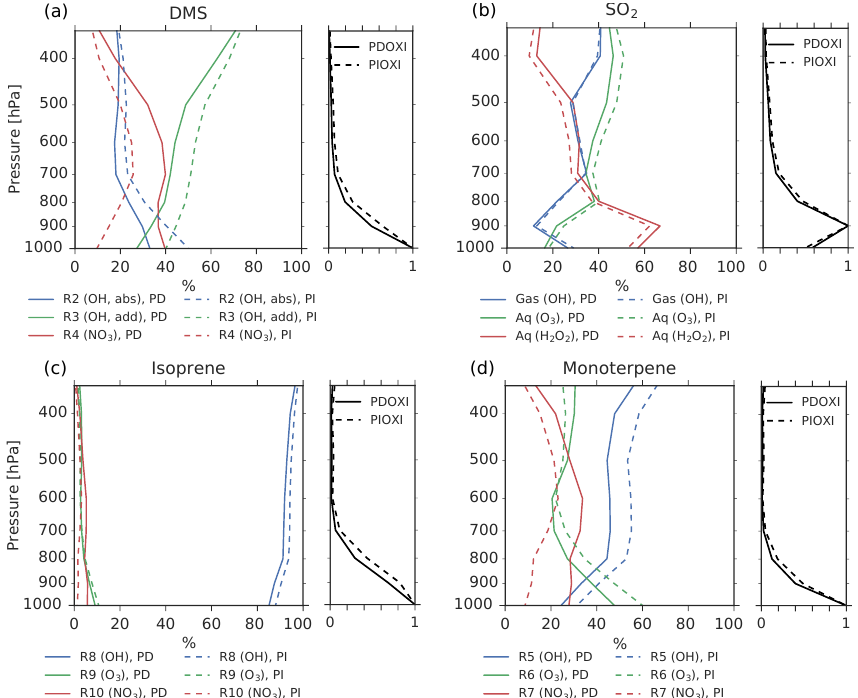
Figure 7. The left panel of each figure shows the importance of different oxidant reactions at different levels for (a) DMS, (b) SO 2 , (c) iso- prene and (d) monoterpene. Solid lines: PD-oxidants, dashed lines: PI-oxidants. The curves indicate the percentage of the total oxidation for each specie that occurs through the specified reactions at a specific height. The sum of the three reactions at each level is equal to 100% in all cases. The right panel of each figure shows how much of the specie is oxidized at each level relative to the level of maximum oxidation.